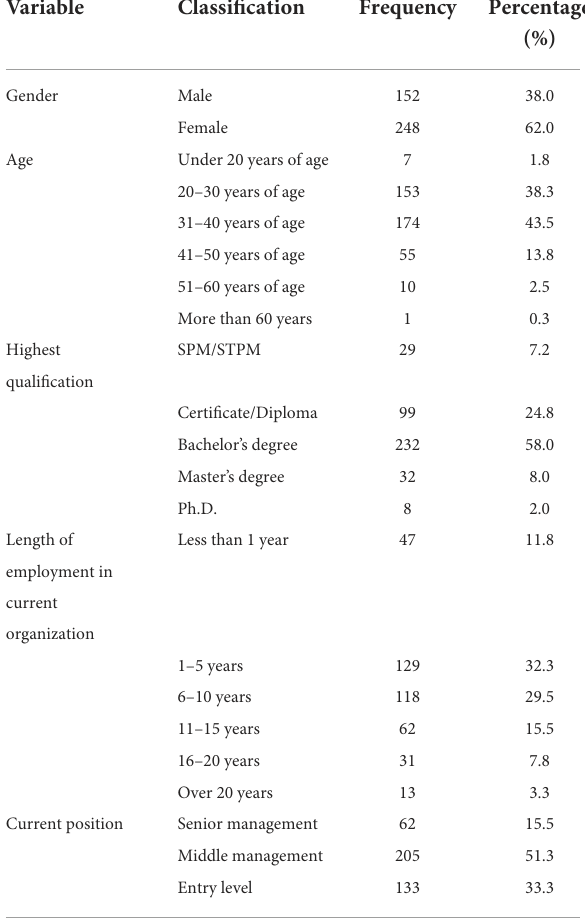
TABLE 1 Demographic profile of